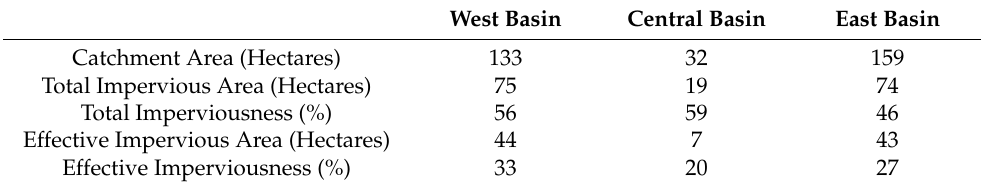
Table 3. Catchment area and imperviousness by basin (2018).